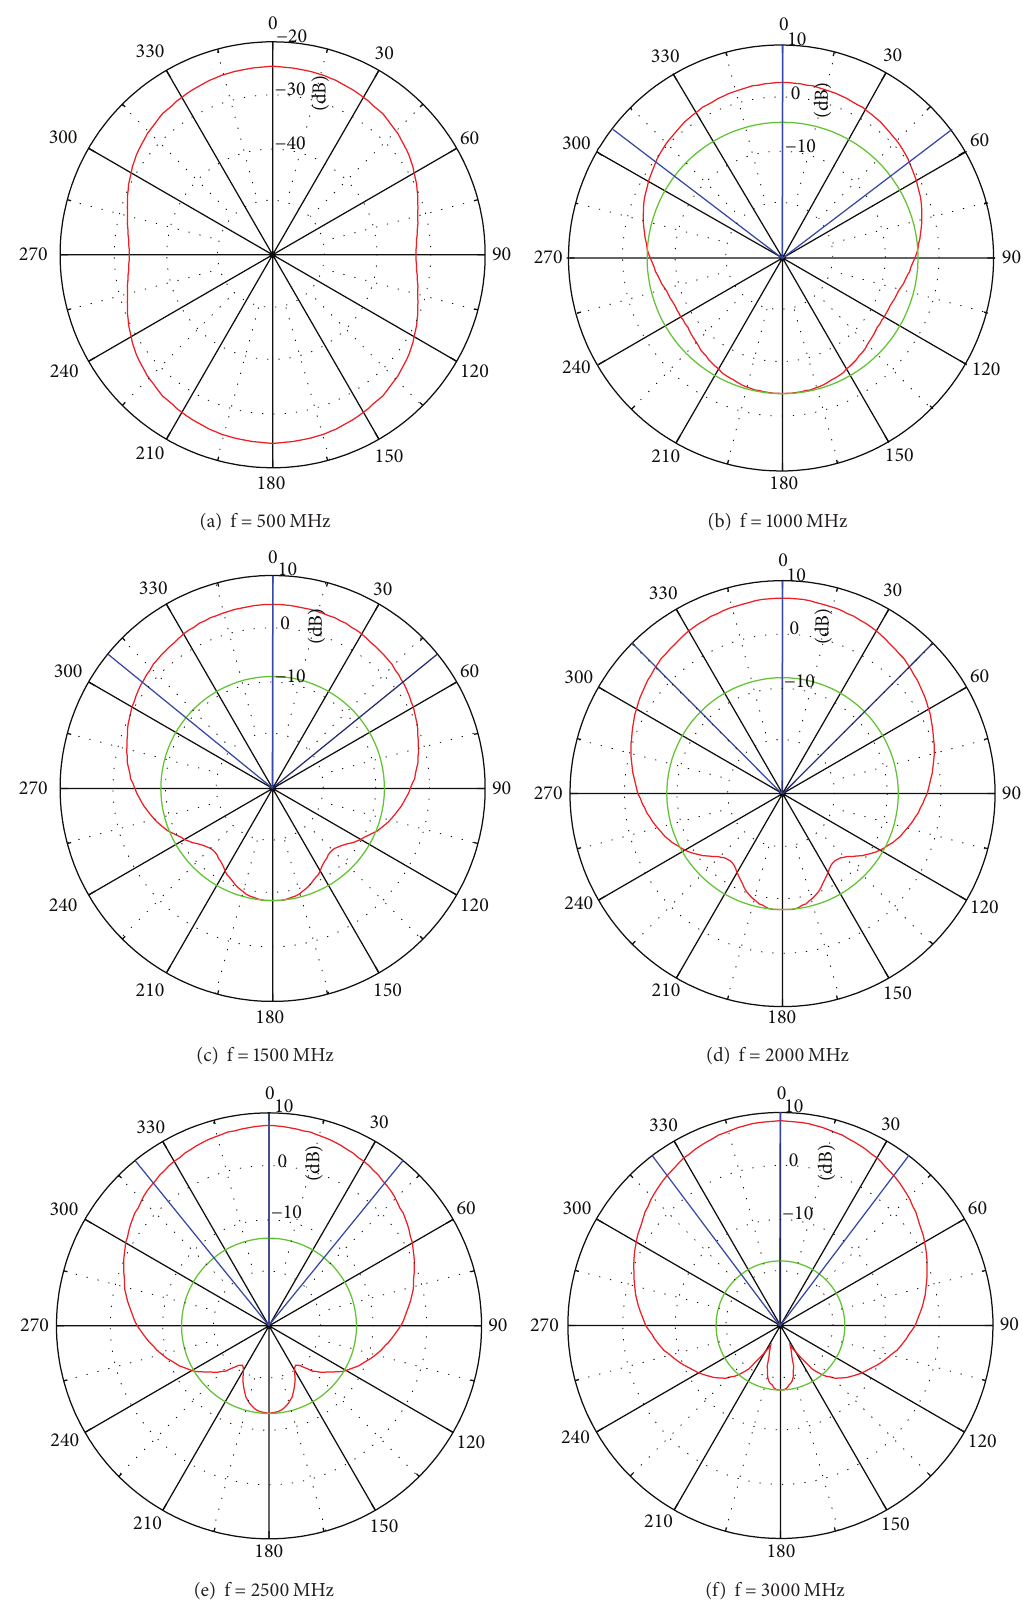
Figure 7: The designed antenna